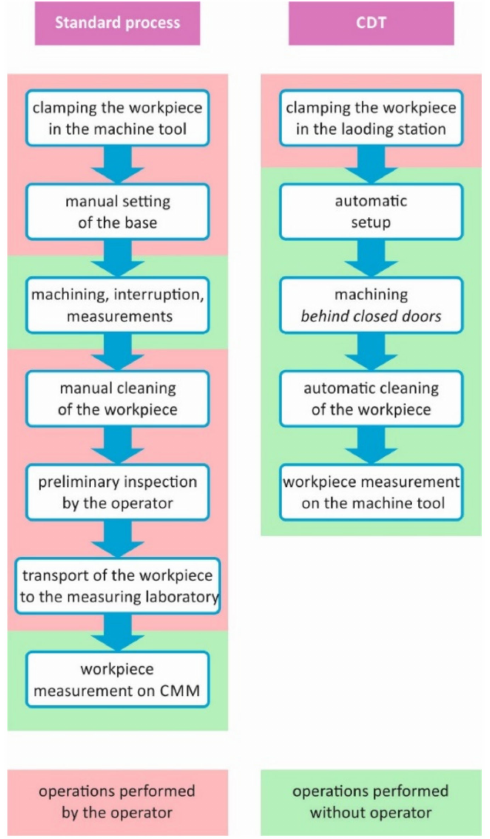
Figure 1. Manufacturing using the standard machining process and CDT